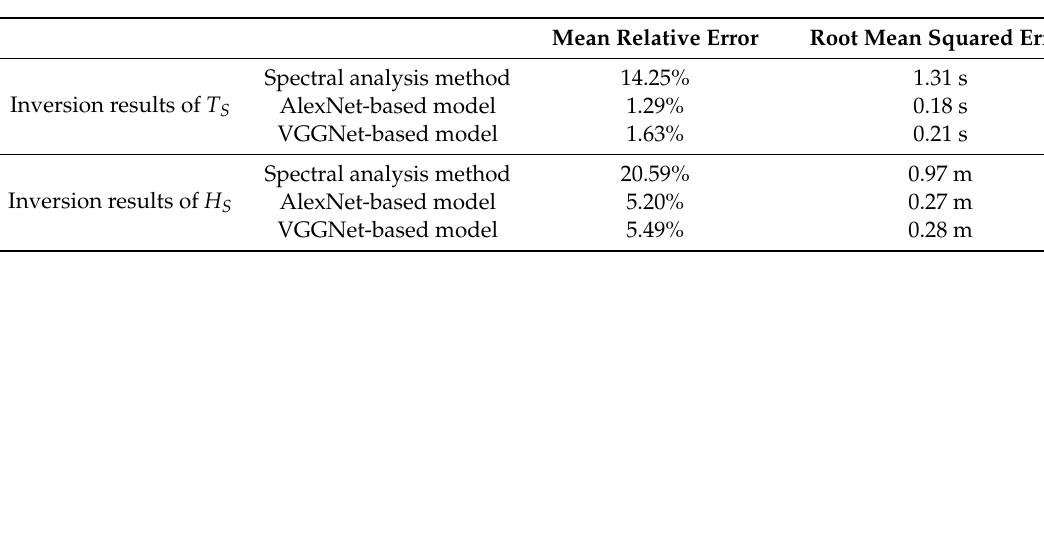
Table 4. Statistical characteristics of results inversed by the spectral analysis and CNN-based